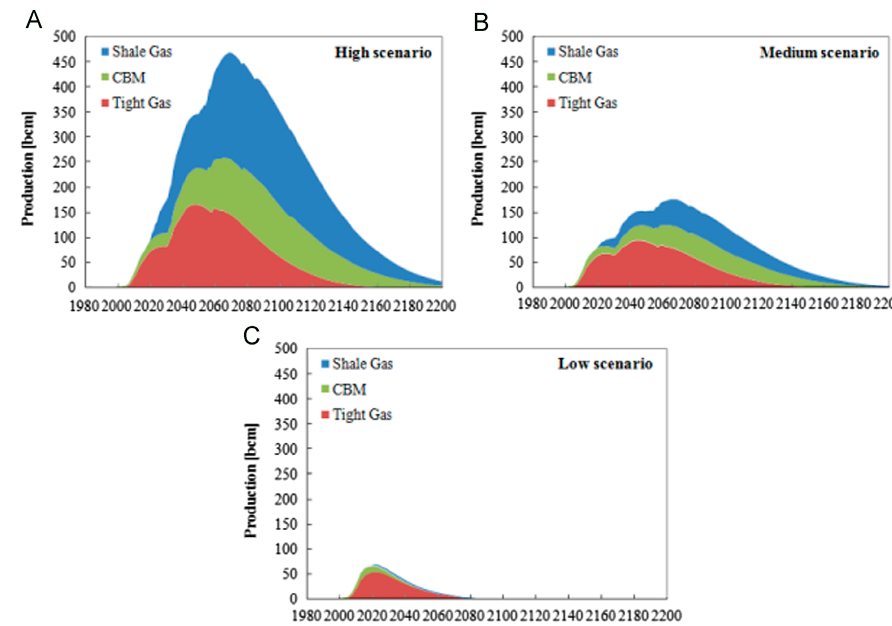
Figure 1. Three scenarios of China’s future unconventional gas production [34]. ( a ) High scenario; ( b ) Medium scenario; and ( c ) Low scenario.